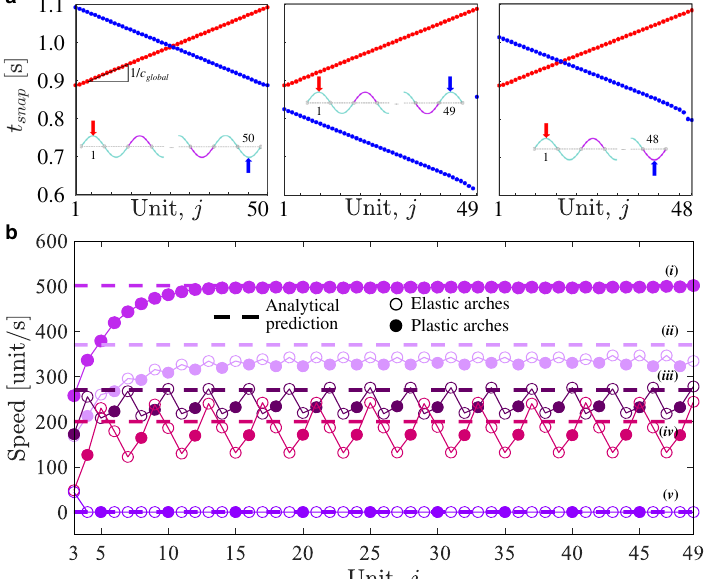
¼ 0.86 s. b Local speed of 49